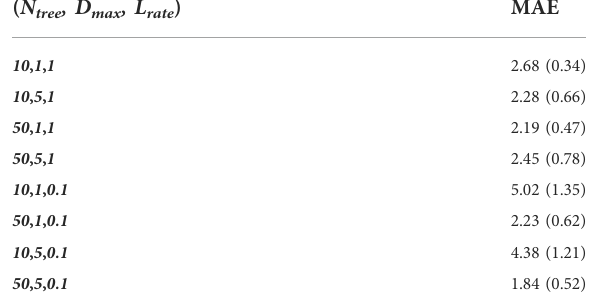
TABLE 4 The results of different parameter for XGBoost model (mean (sd)). ( N tree , D max , L rate